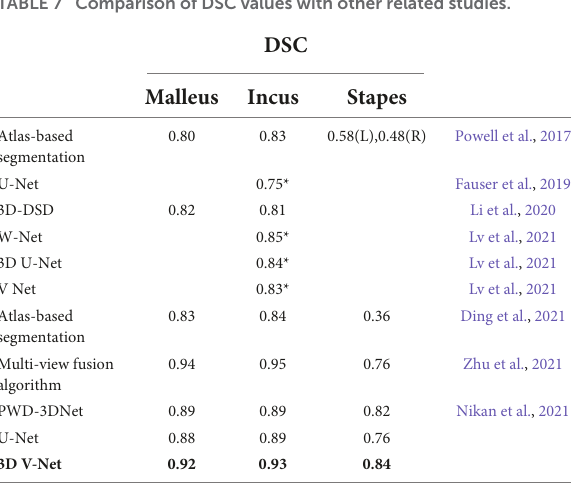
TABLE 7 Comparison of DSC values with other related